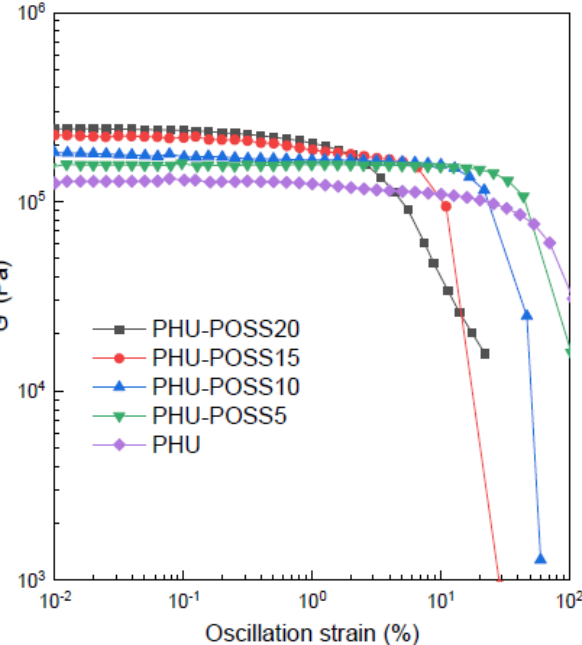
Figure 7. Rheological data of PHU and PHU-POSS nanocomposites with a strain sweep.